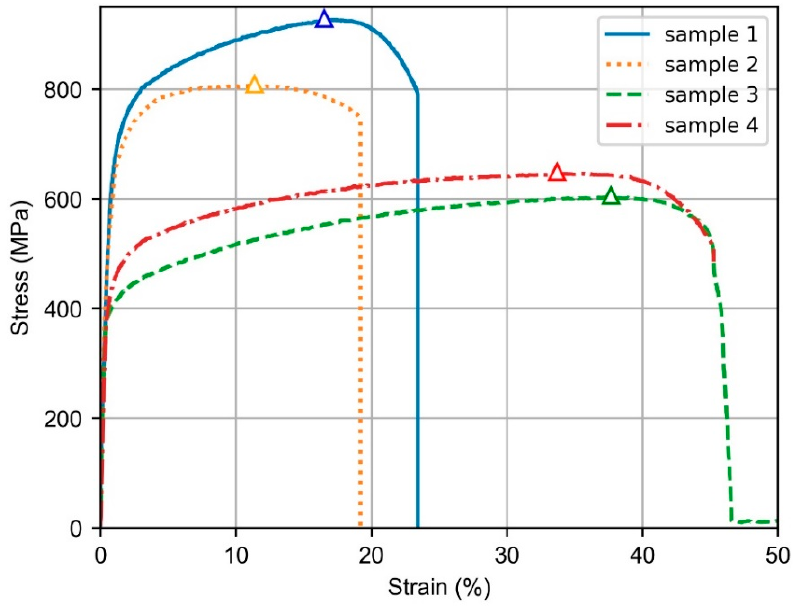
Figure 8. Results of the stress–strain curve for the specimens extracted from the manufactured walls, the triangles show the UTS for each test.